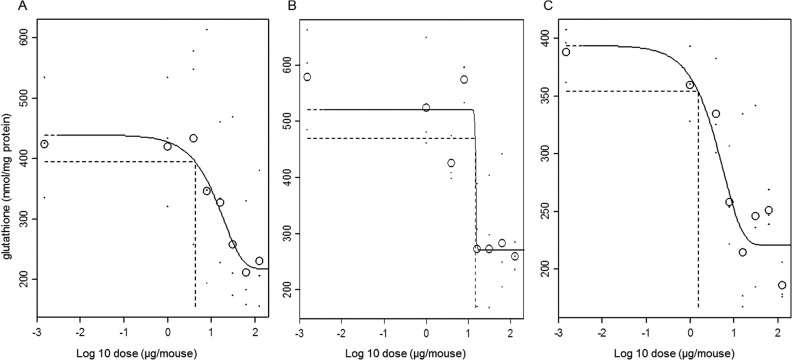
Dose-response relationships for glutathione depletion in the liver.A) non-functionalised ZnO, B) functionalised ZnO and C) Ag NMs. The large symbols represent the (geometric) mean response of the individual responses (small symbols) in each dose group. The horizontal and vertical dashed lines represent the BMR and BMD respectively.